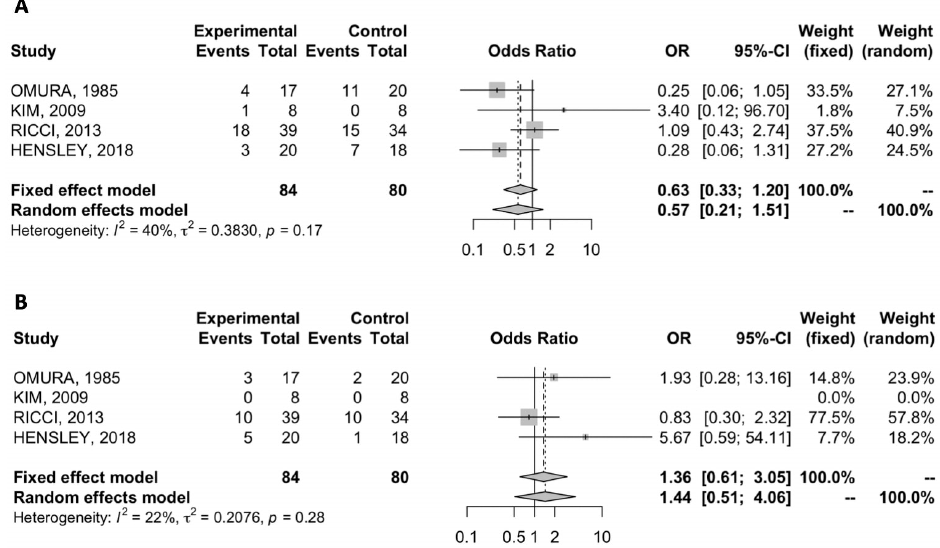
Figure 2. ( A ) Forest plot of comparison between adjuvant chemotherapy versus observation; the outcome was OR of distant recurrence rate; ( B ) forest plot of comparison between adjuvant chemotherapy versus observation; the outcome was OR of locoregional recurrence rate.